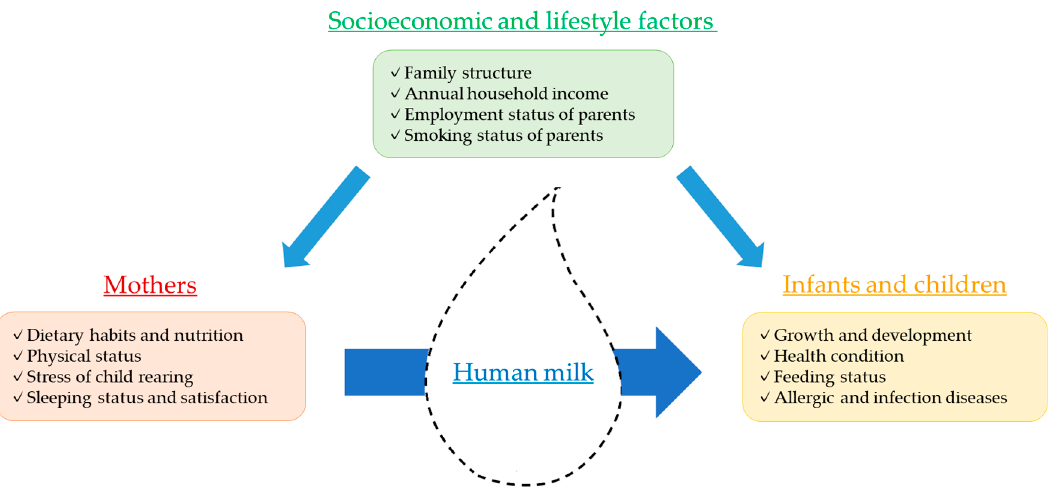
Figure 1. Relationship between mothers, human milk, infants/children, and socioeconomic and lifestyle factors.